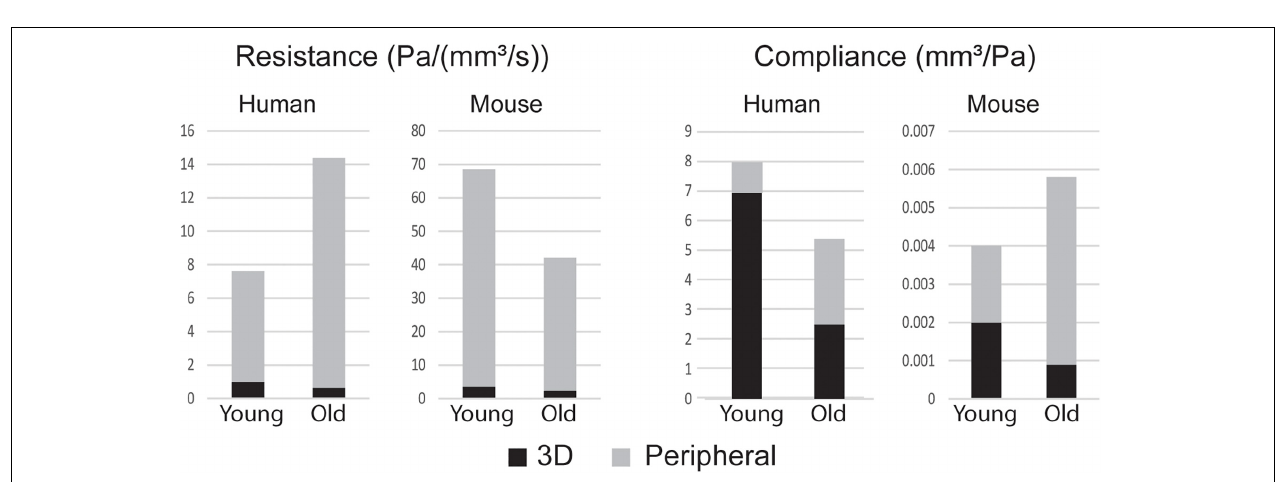
FIGURE 4 | Regional circumferential (C θθθθ ) and axial (C zzzz ) material stiffness and wall thickness h for young adult and old adult humans (top) and mice (bottom) for five locations along the aorta (ATA, ascending thoracic aorta; pDTA, proximal descending thoracic aorta; dDTA, distal descending thoracic aorta; SAA, suprarenal abdominal aorta; and IAA, infrarenal abdominal aorta). The percentages indicate changes with aging relative to the young value. Note that the ATA stiffened the most with aging in humans (cf. Redheuil et al., 2010) whereas the DTA stiffened the most with aging in mice.